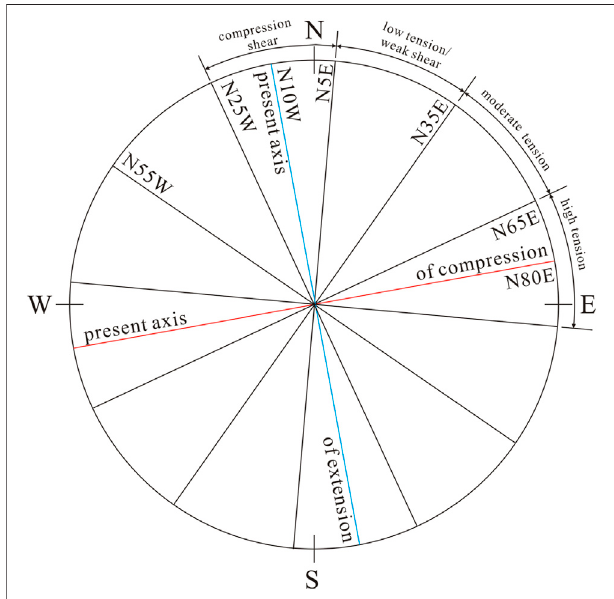
FIGURE 4 | Strike state of the neotectonics faults in the present stress fi led in the study area. The current axis of compression orients N80 ° E.